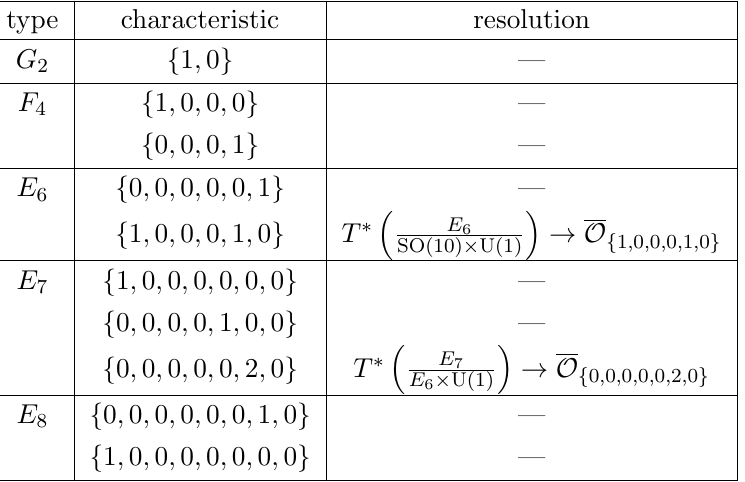
Table 10 . Summary of resolutions of characteristic height two nilpotent orbits for exceptional al-